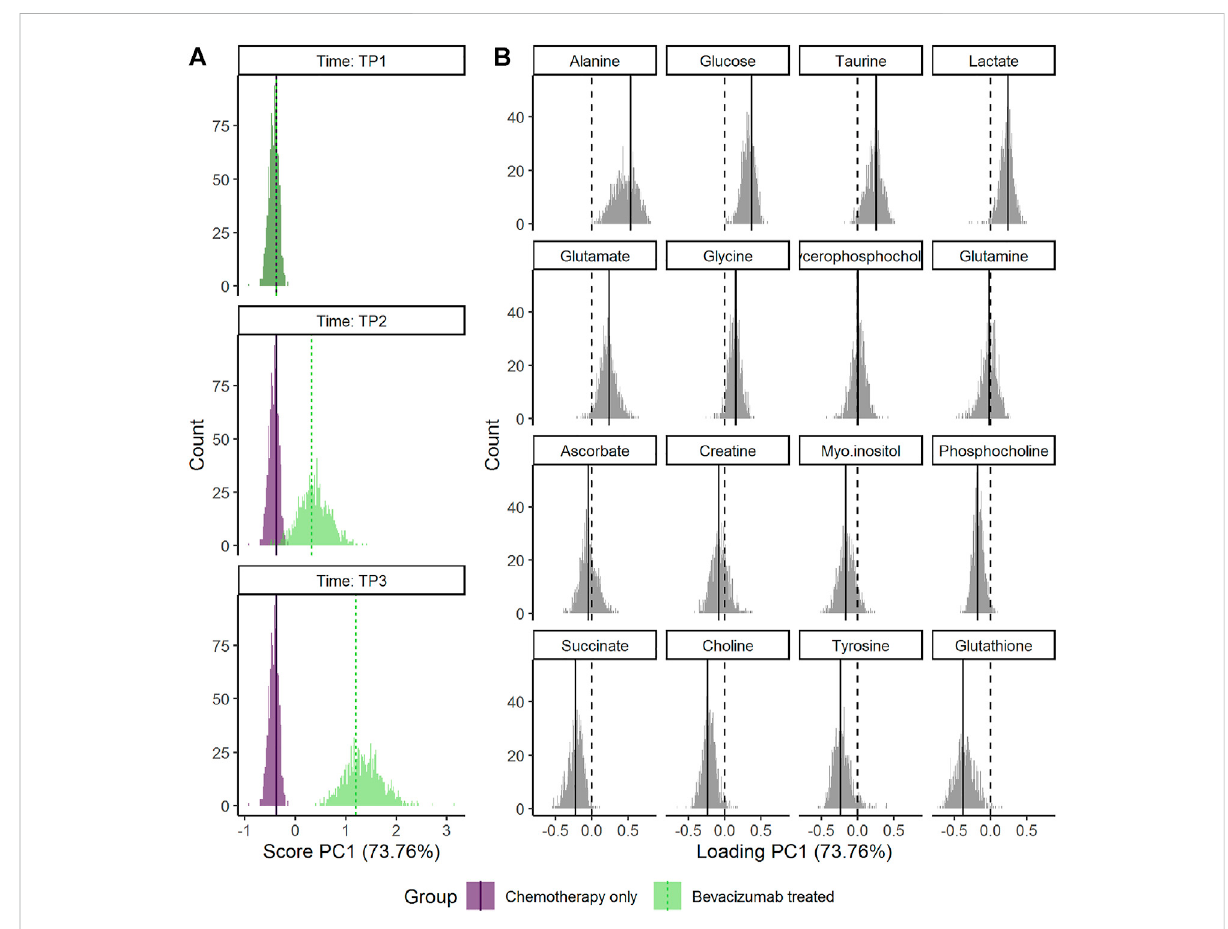
FIGURE 8 Distribution of the bootstrapped parameters (A) scores and (B) loadings for the RM-ASCA + model shown in Figure 7. Main model estimates are shown as vertical line. The dotted lines mark zero. The plot was made with the plot( ... , type = “ histogram ” )